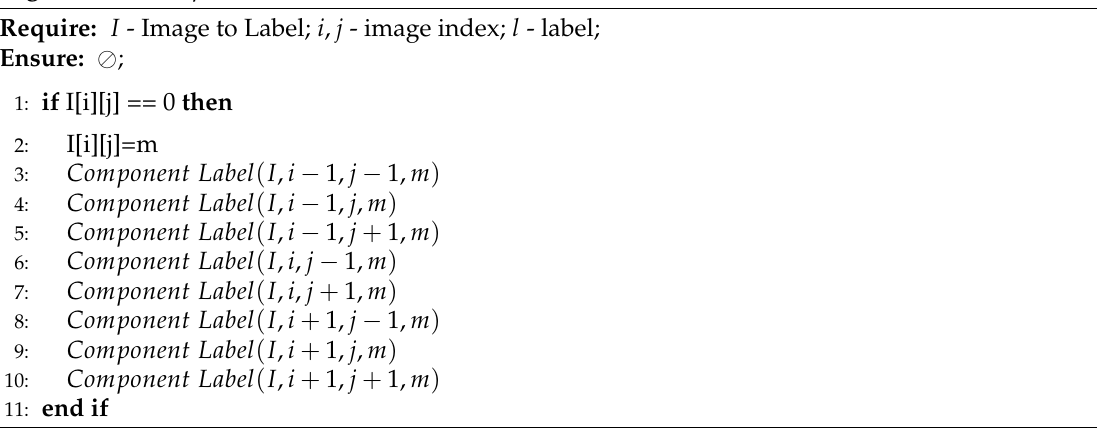
Algorithm 2 Component label .